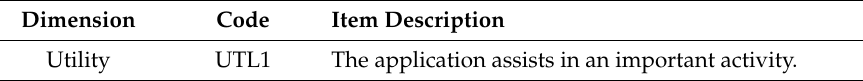
Table 7. The Utility dimension and its items.